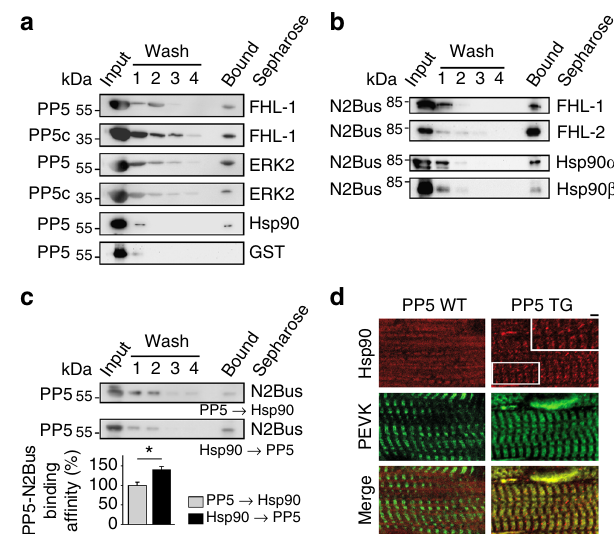
Fig. 5 Passive tension of cardiomyocytes of WT and PP5 TG mouse hearts. a Representative image of permeabilized cardiomyocyte glued at the ends to a force transducer and micromotor, respectively, and experimental protocol. Bar, 20 µ m. b Passive tension ( F passive ) vs. SL curves of permeabilized single PP5 TG and WT cardiomyocytes in relaxing solution, before and after treatment with recombinant PP5c. c F passive -SL curves of permeabilized single PP5 TG and WT cardiomyocytes before and after treatment with ERK2. d F passive – SL curves of permeabilized single WT cardiomyocytes before and after treatment with ERK2 and additional exposure to PP5c. Data are mean ± s.e.m., n = 5 cells/condition (2 different hearts/condition). Curves are second-order polynomial fi ts to the